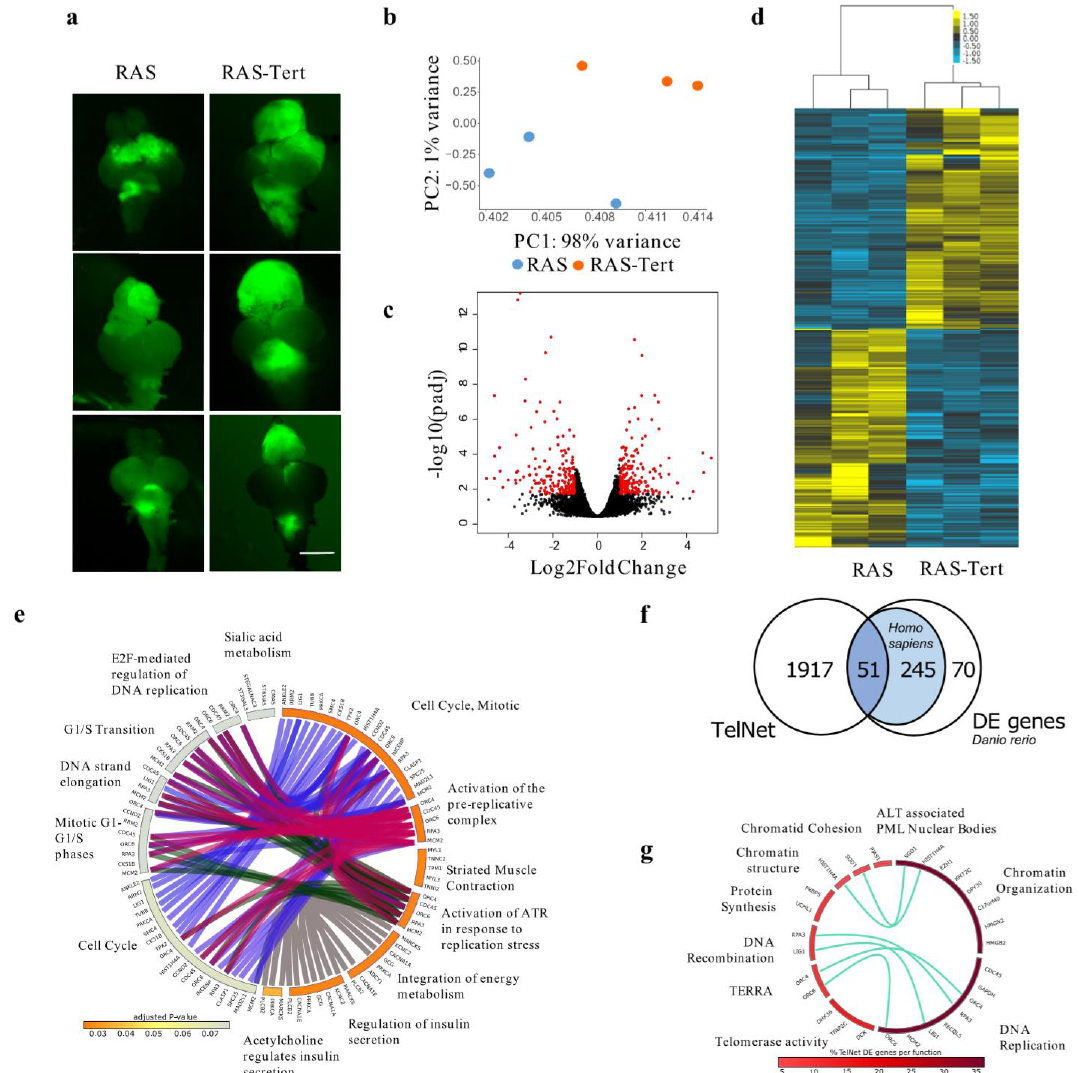
Figure 1. Analysis of RNA-Seq showed a class of genes altered in zebrafish brain tumors with di ff erent TMMs. ( a ) Images showing zebrafish RAS and RAS-Tert brains used for the RNA-Seq analysis. The expression of eGFP-HRASV 12 was induced in a population of brain progenitor cells using the driver line zic:GAL4 [16]. The tumour masses in 1-month old fish are visualised through eGFP expression. Scale bar: 0.5 mm. ( b ) Principal component analysis (PCA) of the gene expression counts (Trimmed Mean of M-values, TMM) showing the first versus the second principal component (PC). Samples in the two conditions are highlighted in di ff erent colors. ( c ) Volcano plot representing − log10 Benjamini-Hochberg (BH) adjusted p -value and log2 Fold Change of genes in the comparison RAS and RAS-TERT. In red di ff erentially expressed genes with adjusted p -value < 0.05 and log2 Fold Change > 1 or < − 1 are highlighted. ( d ) Heatmap showing the 366 di ff erentially expressed genes between brain tumors from RAS and RAS-Tert, hierarchically clustered with average linkage and uncentered correlation metric with cluster3, and displayed with tree view. ( e ) Circular bar representing Reactome pathways enrichment for the DE gene set, colored according to adjusted p -value, with the most significant in orange, drawn with circos. DE genes in the pathways are indicated on the bars and are connected to the same genes in other pathways. ( f ) Venn diagram showing the number of di ff erentially expressed genes between RAS and RAS-Tert brain tumors, which have a human ortholog and are present in TelNet database. ( g ) Circular plot depicting TelNet functions of the di ff erentially expressed genes reported in TelNet database and their connections.